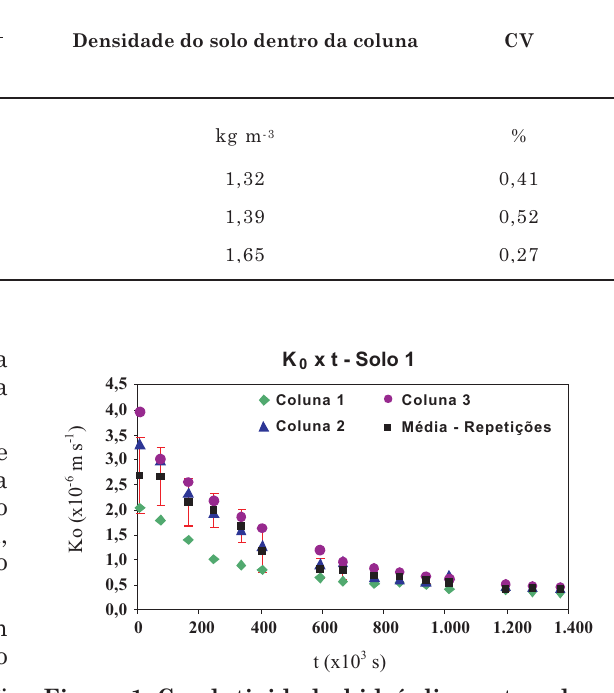
Figura 1. Condutividade hidráulica saturada em função do tempo (solo 1), média das repetições e respectivos desvios-padrão (barras